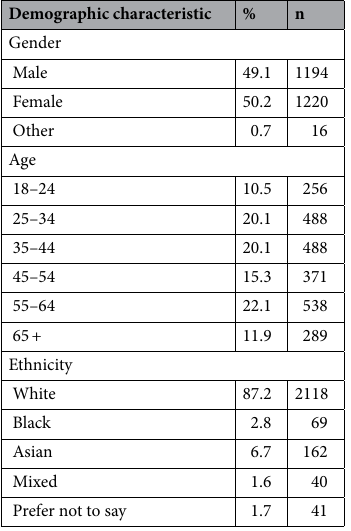
Table 1. Demographic composition of the final sample.